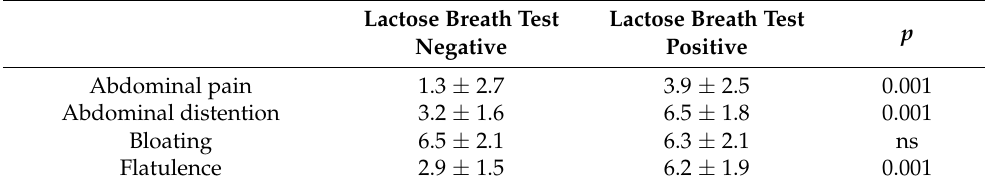
Table 3. Severity of common lactose intolerance symptoms in patients with and without lactose